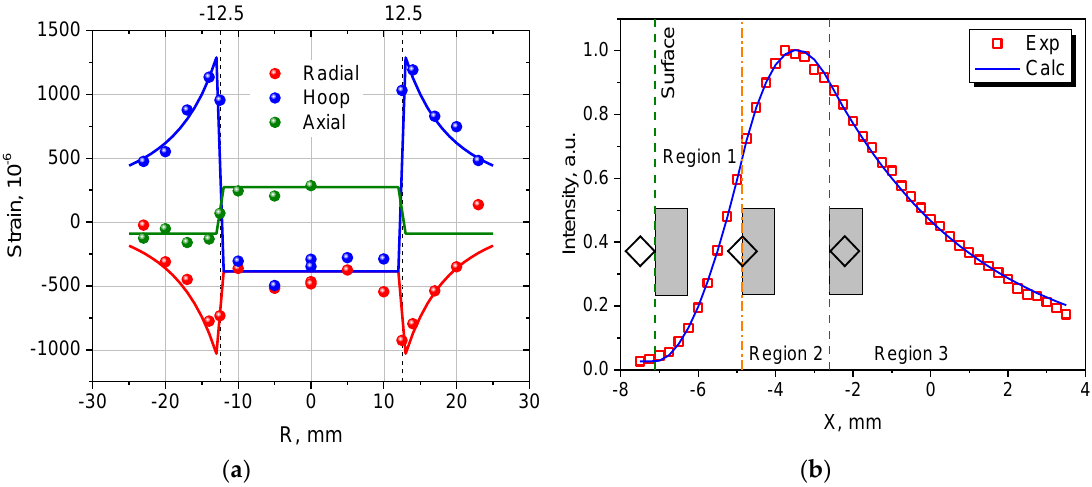
Figure 8. ( a ) Residual lattice strain measured in VAMAS shrink-fit ring and plug sample (set #1); ( b ) Sample surface scan using a radial collimator: diffraction peak intensity vs. gauge volume position in the material depth, adapted from [25], with permission from © 2010 Springer.